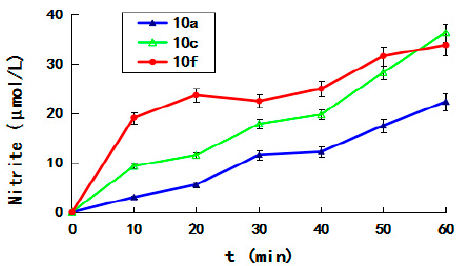
Figure 3. Griess assay of compounds 10a , 10c and 10f measured at the time points of 0, 10, 20, 30, 40, 50, and 60 min.